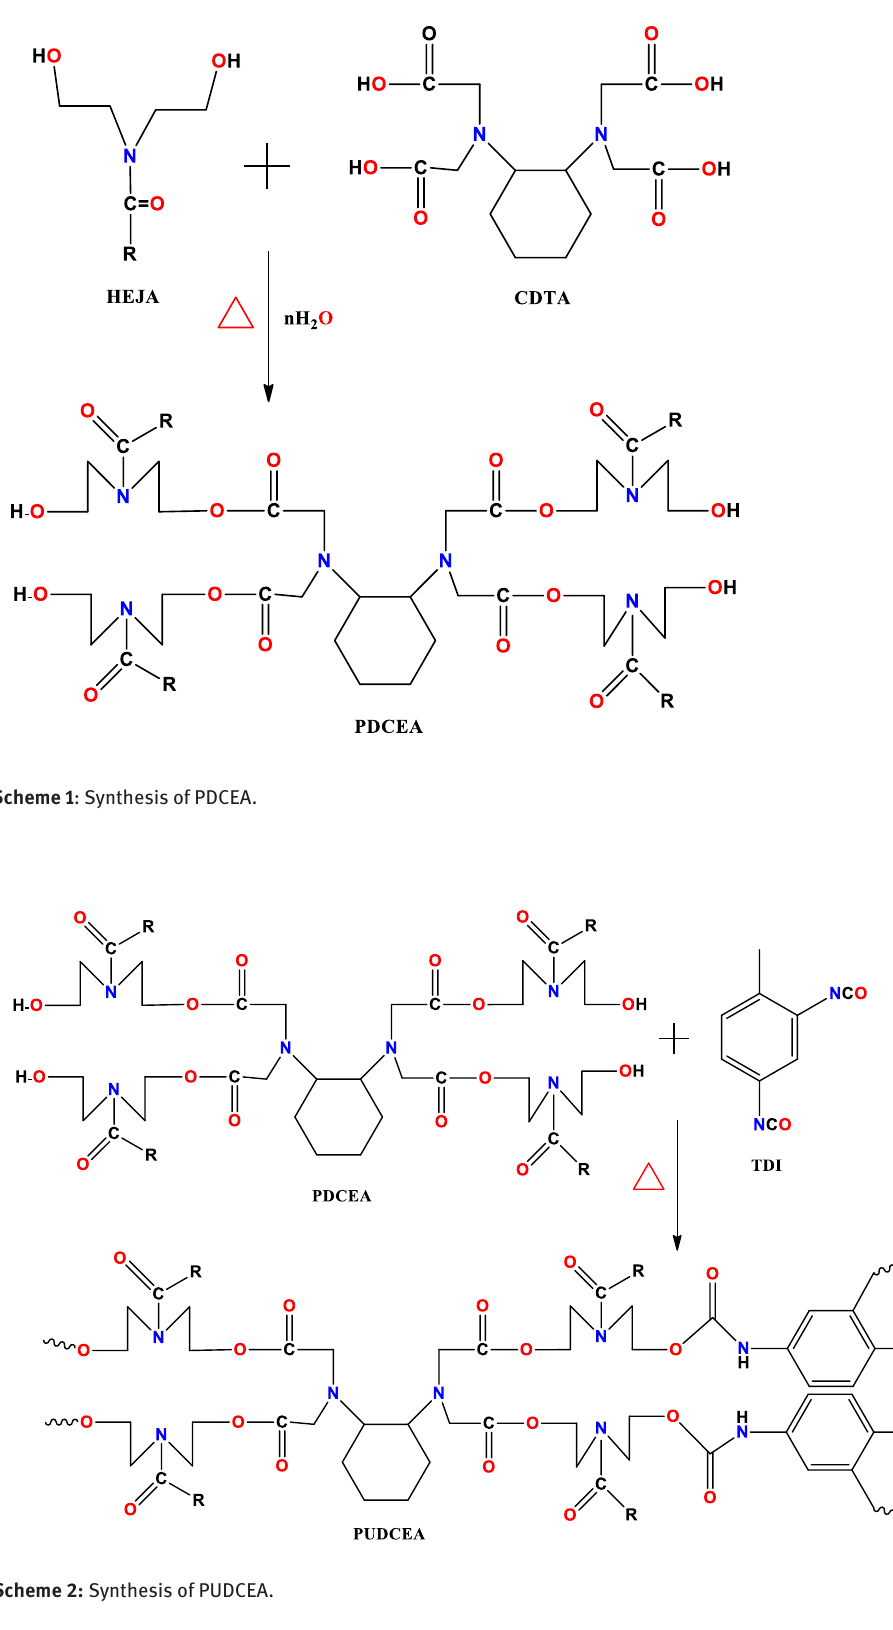
Scheme 2. Synthesis of PUDCEA